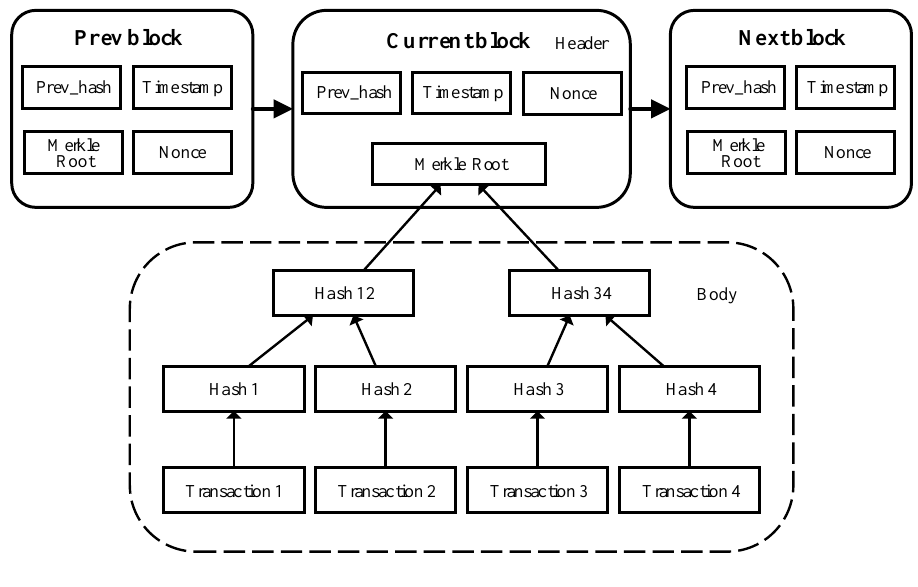
Figure 1. Block structure of blockchain